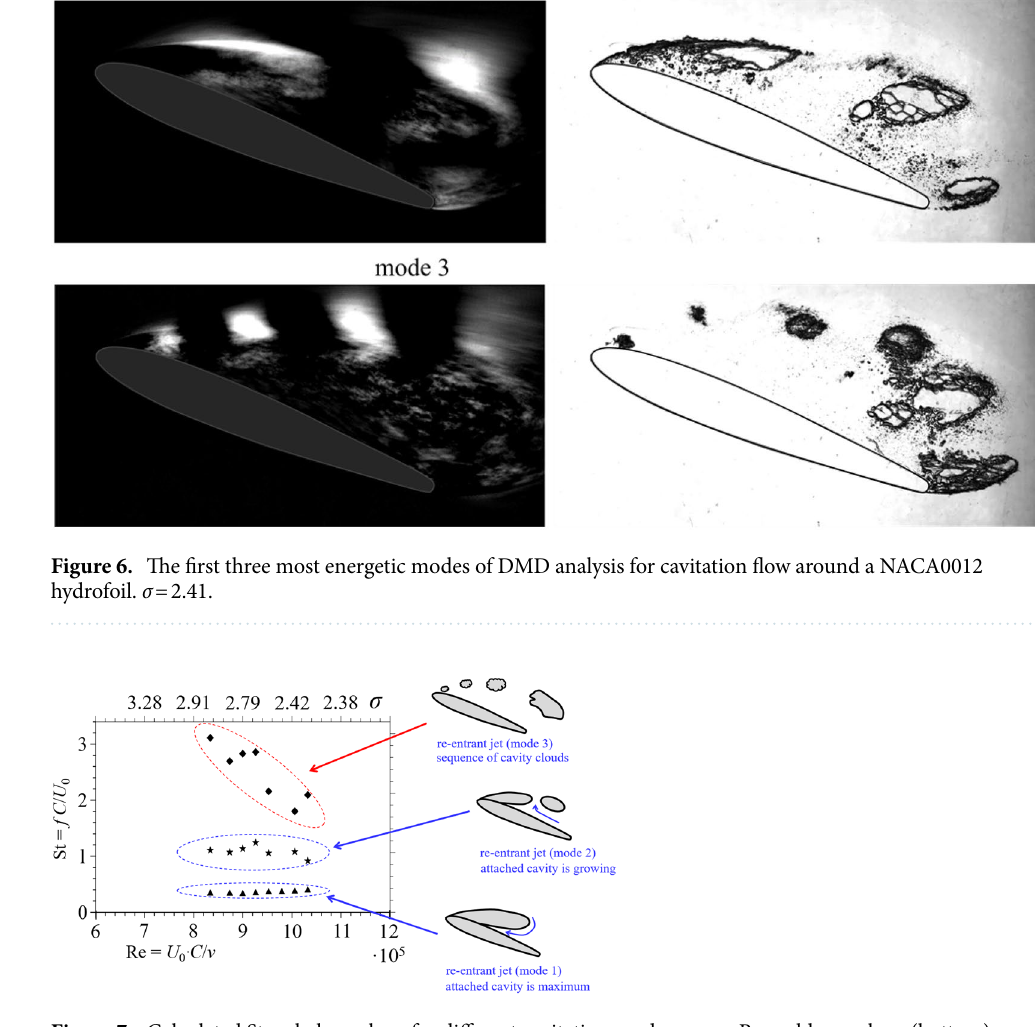
Figure 7. Calculated Strouhal numbers for different cavitation modes versus Reynolds numbers (bottom) cavitation numbers